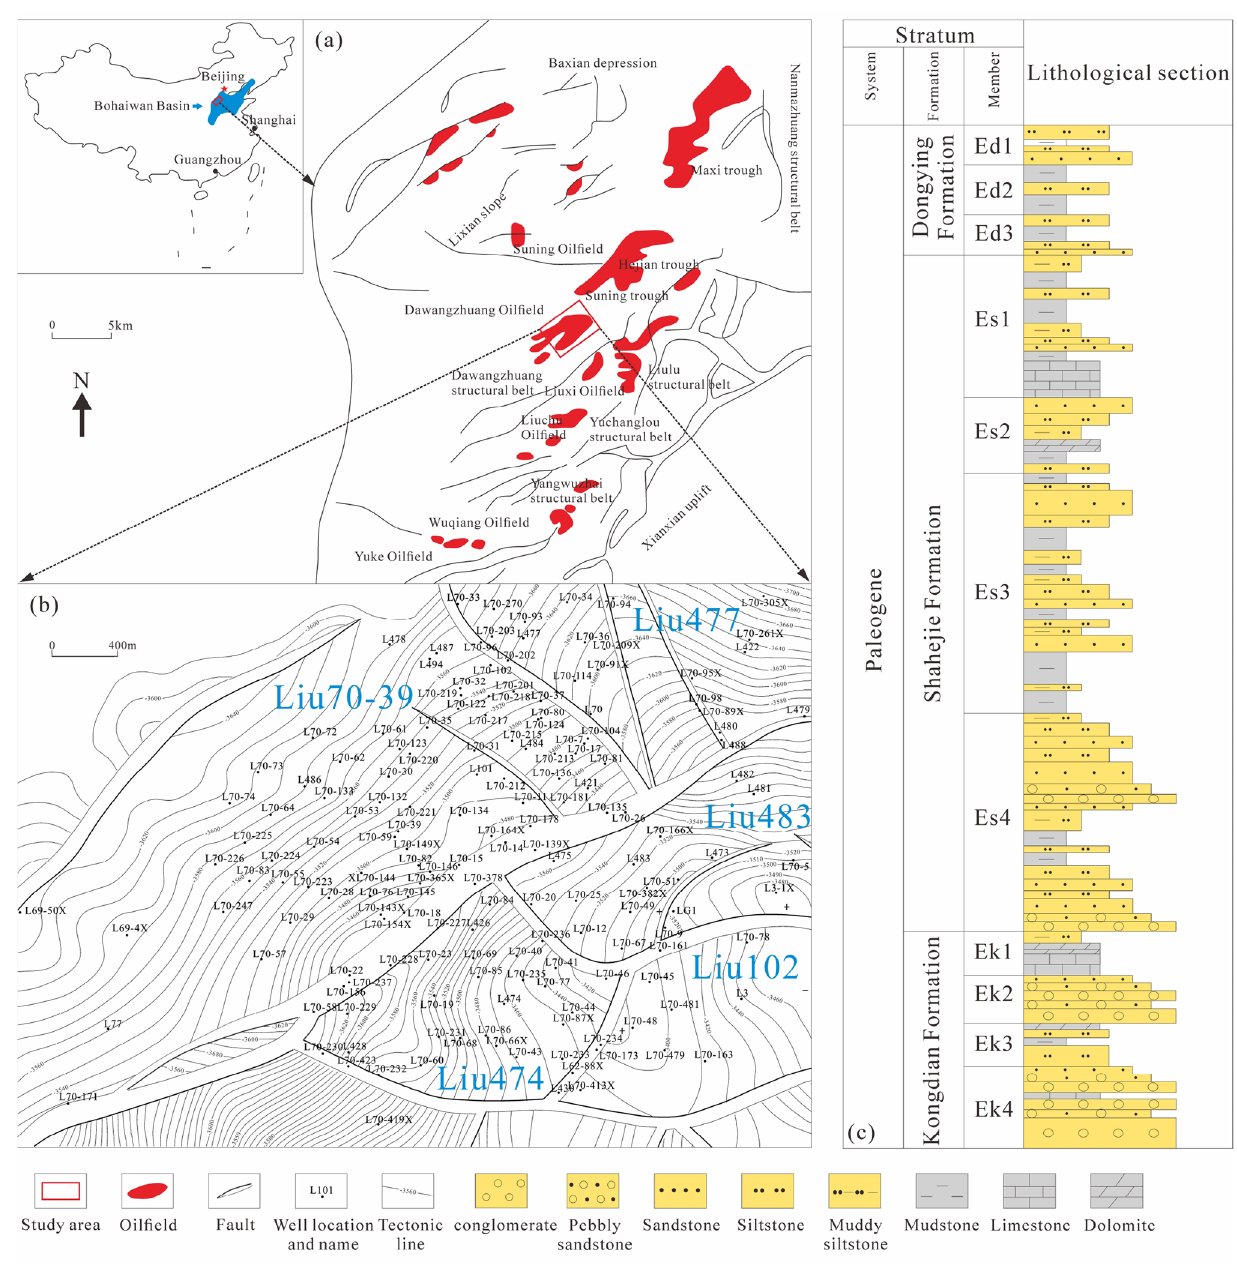
Fig. 1 Location of Raoyang sag ( a ), structure location of the study area ( b ) and stratigraphic column in the study area ( c